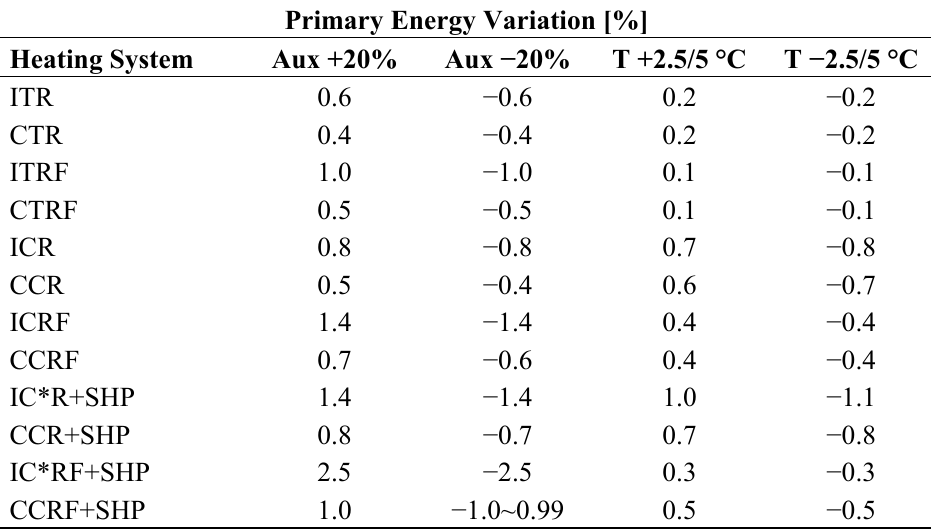
Table 7. Influence of auxiliaries and operating temperature on primary energy